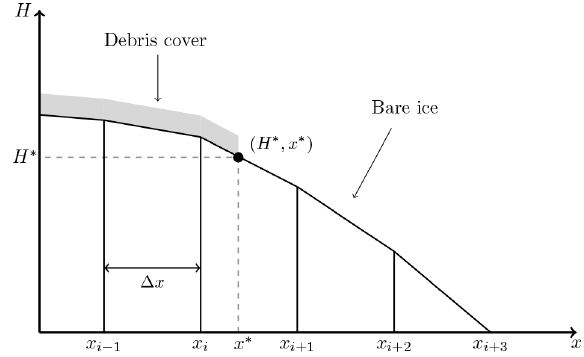
Figure A2. Schematic representation of the model terminus bound- ary condition. Debris covers the glacier only until a point x ∗ , corre- sponding to a critical glacier thickness H ∗ , and past this point the glacier is